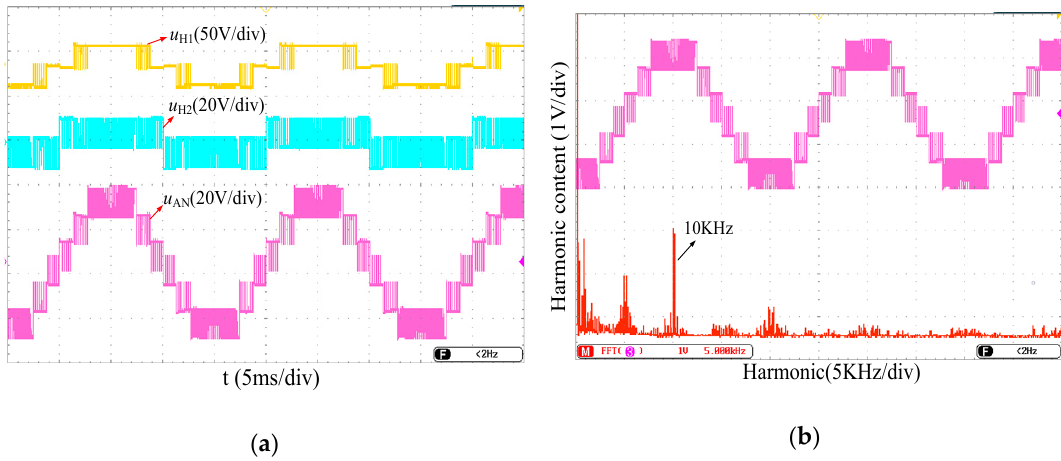
Figure 13. Experiment result (m = 0.9, frl = 5 KHz). ( a ) Output voltage and phase voltage waveform of each unit. ( b ) Phase voltage spectrum.